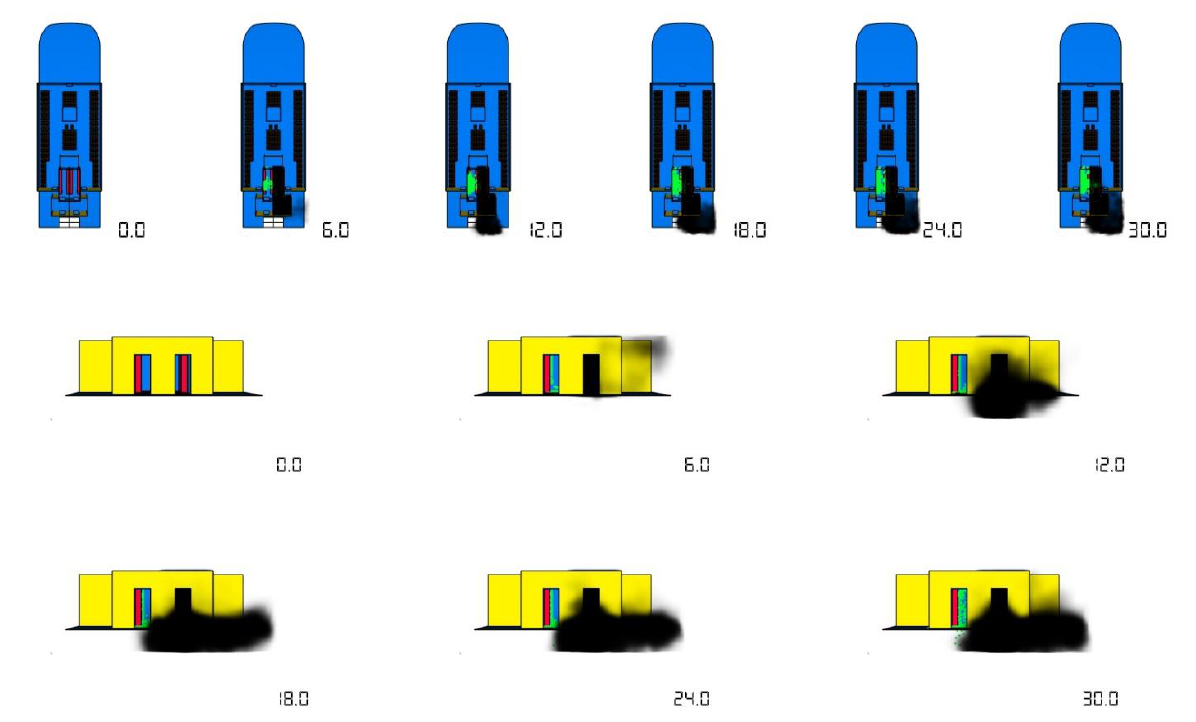
Figure 20. Simulation of scenario 6.